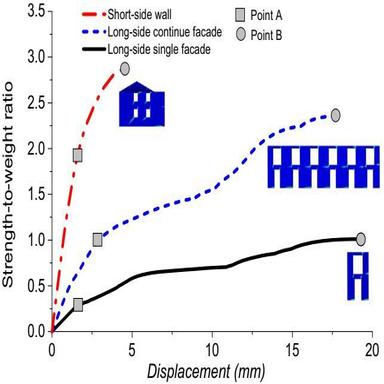
Strength-to-weight ratio versus displacement curves.